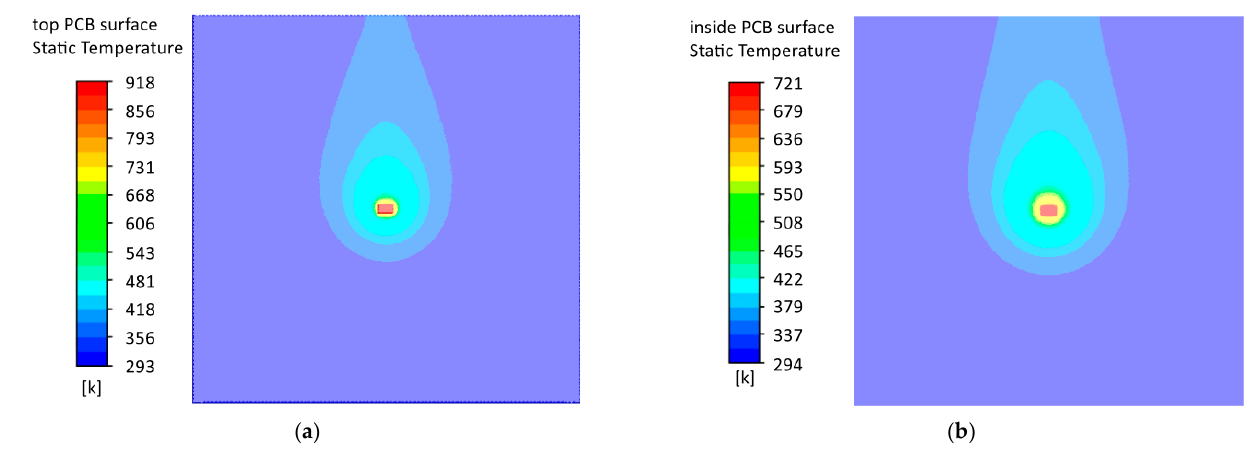
Figure 8. Heat distribution according to models without a copper layer under natural convection conditions: ( a ) surface component; ( b ) embedded component.